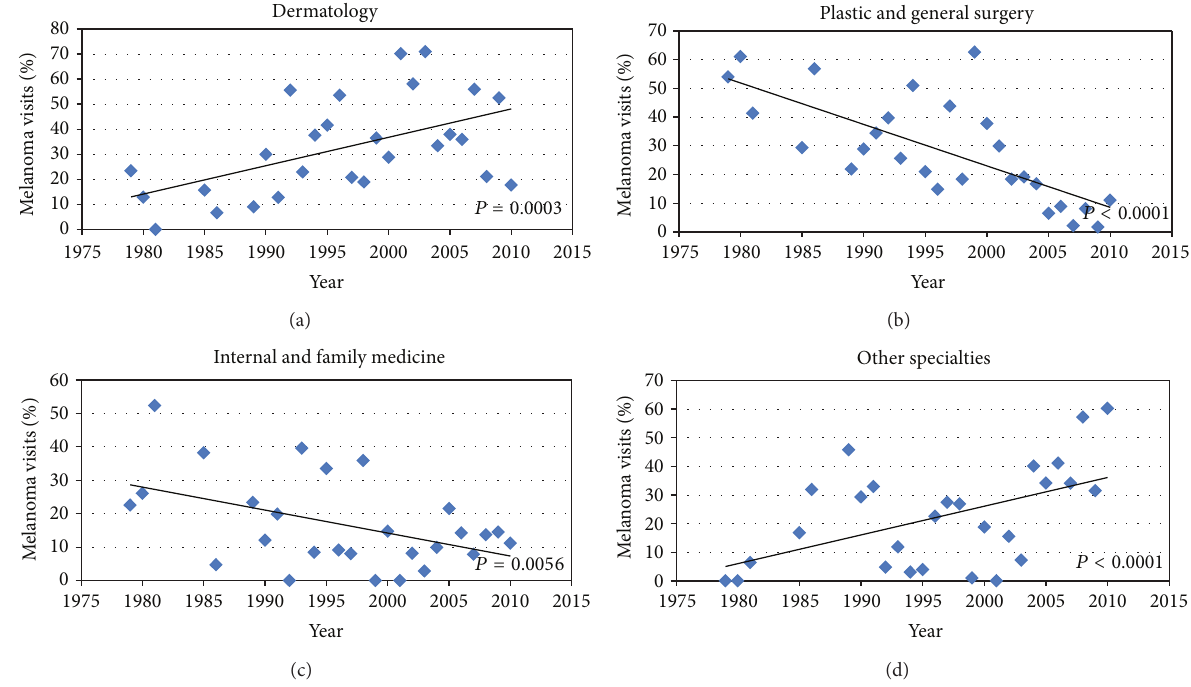
Figure 4: Proportion of melanoma visits by specialty from the US National Ambulatory National Care Survey (NAMCS) from 1979 to 2010 in (a) dermatology, (b) plastic and general surgery, (c) internal and family medicine, and (d) other